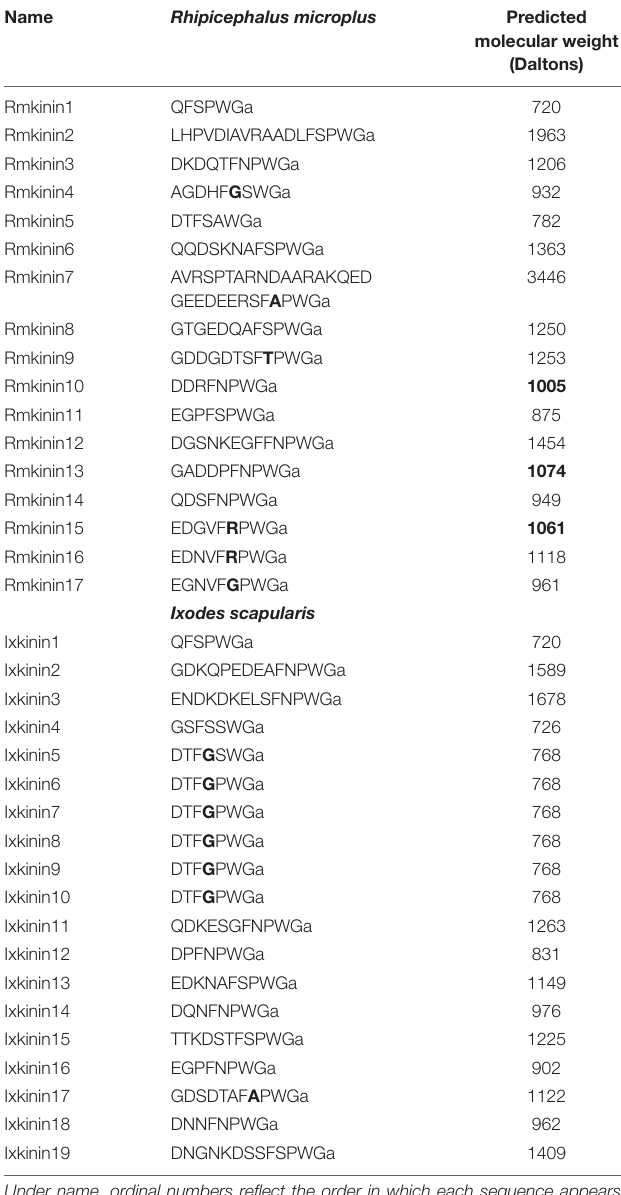
TABLE 1 | Predicted bioactive kinins from Rhipicephalus microplus and Ixodes scapularis.